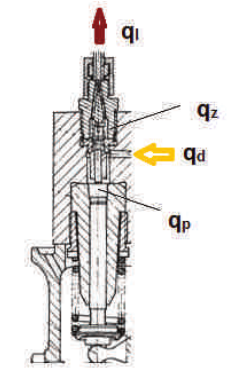
Fig. 4. Structural subsystem of the injection pump: q d - stream of fuel reaching the injection pump,: q t - stream of fuel pumped by the crowd, q z - stream of fuel flowing through the delivery valve, q - stream of fuel l flowing into the injection pipe